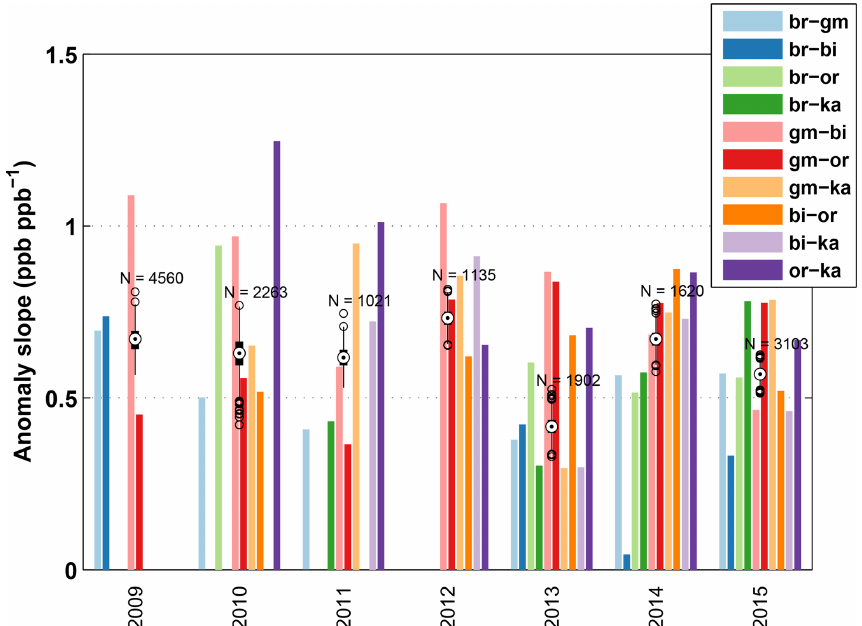
Figure 2. The bars show the methane to carbon monoxide anomaly slopes for each site pair. The method of computing these anomaly slopes is detailed in Sect. 2 of the main text. The black targets indicate the median value of the slope for that year, when all site pairs are considered simultaneously, and the 25th and 75th quartiles of the median value are indicated by the vertical black bars. Outliers are indicated by open black